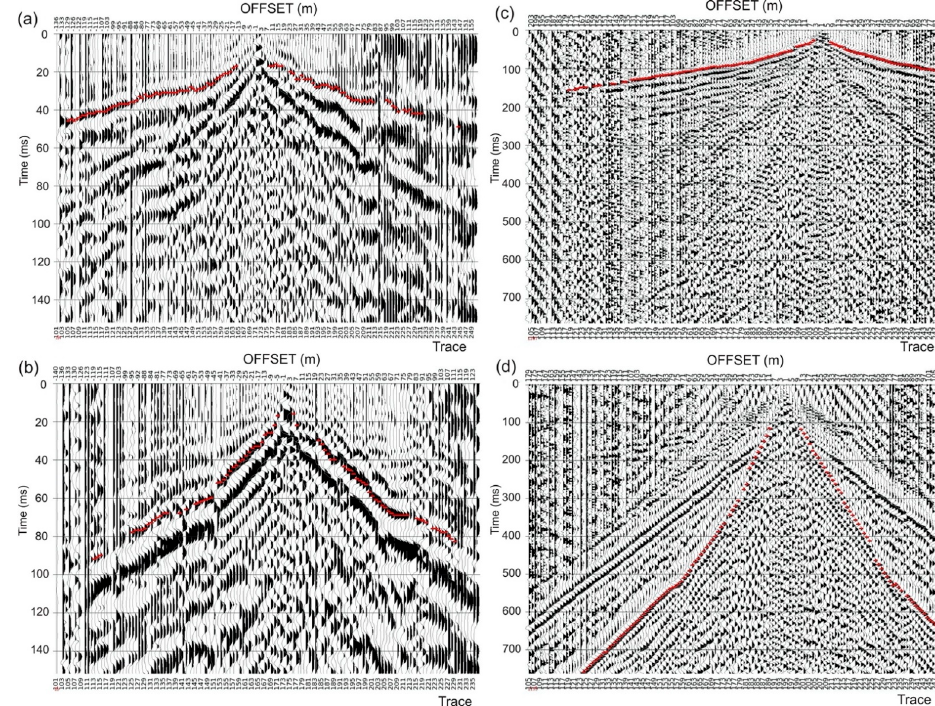
Figure 3. Examples of first-break picking on common shot gathers. Highlighted in red are the picked travel times. ( a ) P-waves from the Croatian site. ( b ) SH-waves from the Croatian site. ( c ) P-waves from the Italian site. ( d ) SH-waves from the Italian site.